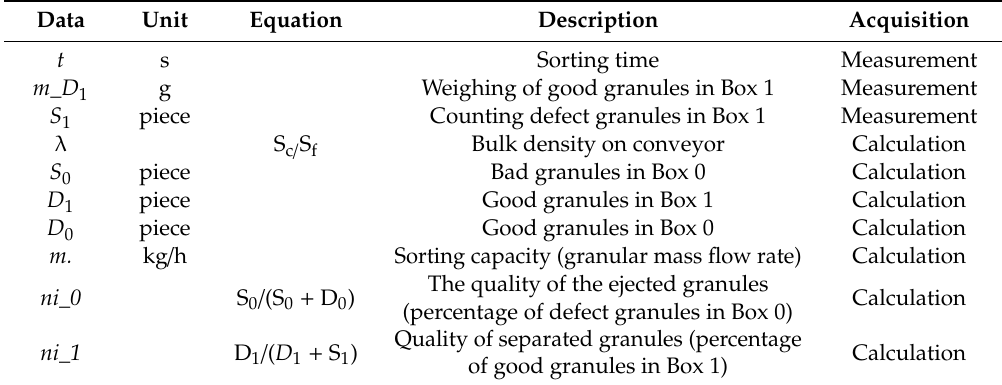
Table 5. The settings of the feeder and the conveyor when testing the sorting efficiency. Table 6. Parameters’ interpretations in sorting machine testing. Test Name